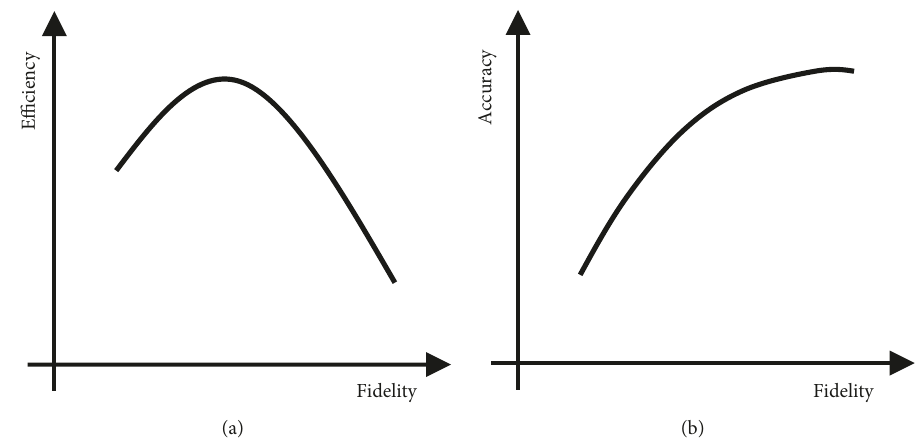
Figure 1: The impact of topological fidelity on the efficiency and accuracy of traffic